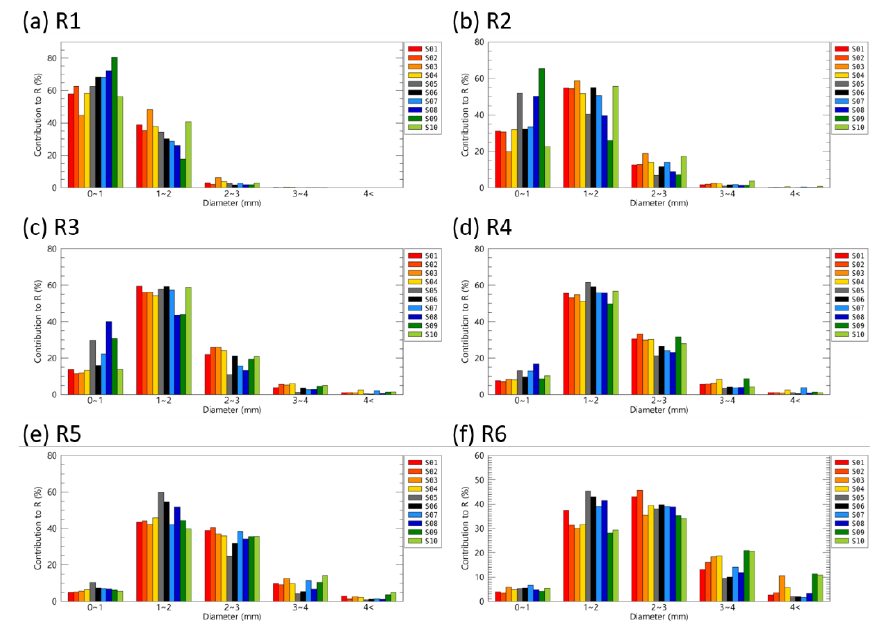
Figure 7. The contribution rate of the N(D) of each diameter category to the rain rate.